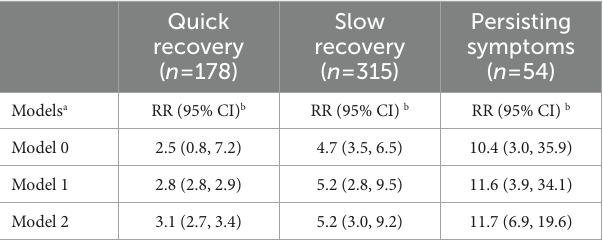
TABLE 3 Use of psychotropic medications to predict belonging to a trajectory: multivariate polynomial analysis. * Quick